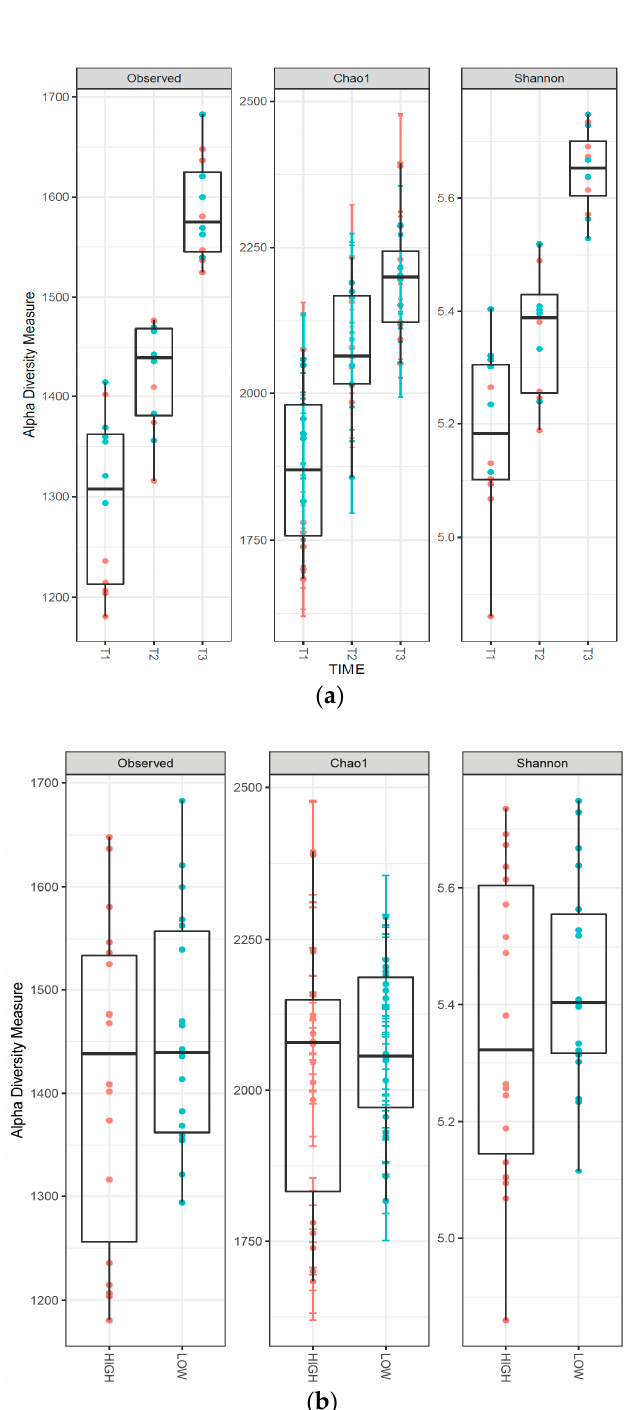
Figure 1. Box plots of the alpha diversity indexes (observed, Chao1 and Shannon) as a function of ( a ) sampling time and ( b ) protein level (high, red dots; or low, blue dots). T1, T2, and T3 correspond to fecal samplings after weaning and before the change of feeding, before the change of housing, and at the end of the experiment (end of the post-weaning period), respectively.